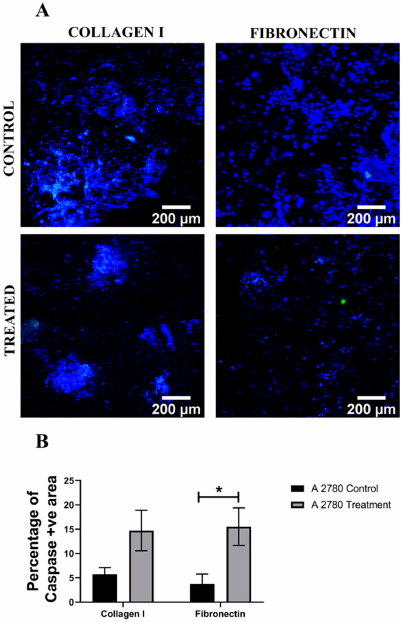
Figure 9. Effect of the chemotherapeutic Cisplatin on the apoptosis A2780 cells grown in PU scaffolds of various protein coatings, 24 h post-treatment ( A ): Representative images for caspase 3/7 (apoptosis)–DAPI (green–blue) staining in collagen I- and fibronectin-coated treated and untreated (control) A2780 polymeric scaffolds ( B ) Image analysis-based quantification of apoptotic (green) image areas for A2780 cells grown in collagen I and fibronectin coated polymeric scaffolds. Scale bar = 200 μ m. Quantitative data represent mean ± SEM for multiple images ( ≥ 3) and multiple scaffolds ( ≥ 3). * p ≤ 0.05 .